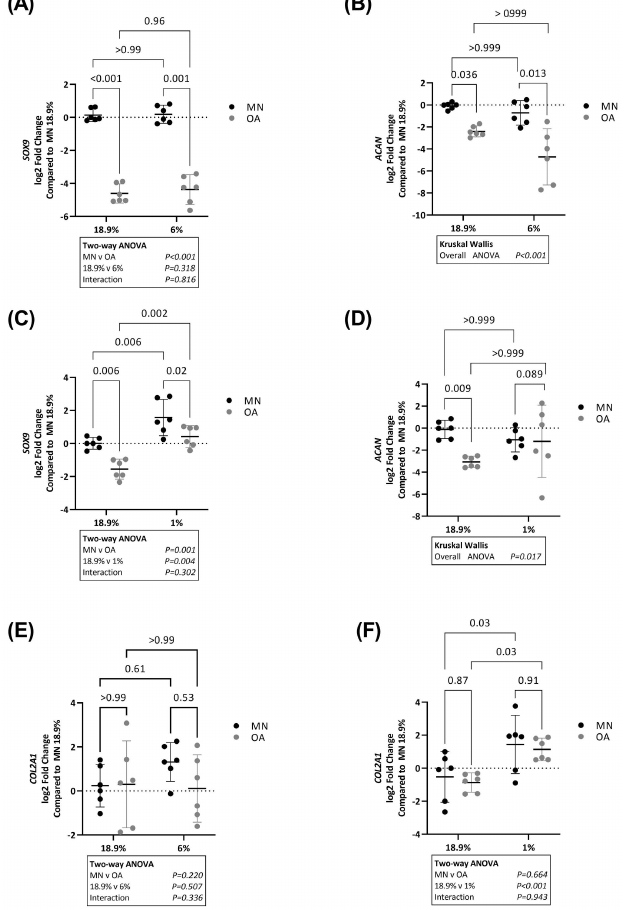
Figure 2. mRNA levels of SOX9, COL2A1 and ACAN, in OA chondrocytes and chondrocytes from macroscopically normal cartilage maintained in 18.9% compared to 6% or 1% oxygen. Paired samples of human chondrocytes isolated from macroscopically normal (MN) and osteoarthritic (OA) cartilage regions within OA joints from six patients were plated in duplicate plates. One plate was transferred to a standard tissue culture incubator (18.9% oxygen) and the other transferred to a hypoxia incubator maintained at either 6% or 1% oxygen for 24 h. Chondrocytes from a different six patients were used to compare the effects of 18.9% vs. 1% oxygen than those used to compare the effects of 18.9% vs. 6% oxygen. Comparison of RNA levels (measured by qPCR) of ( A ) SOX9 and ( B ) ACAN in cells maintained in 18.9% vs. 6% oxygen and ( C ) SOX9 and ( D ) ACAN in cells maintained in 18.9% vs. 1% oxygen. Expression of ( E ) COL2A1 in cells maintained in 18.9% vs. 6% oxygen